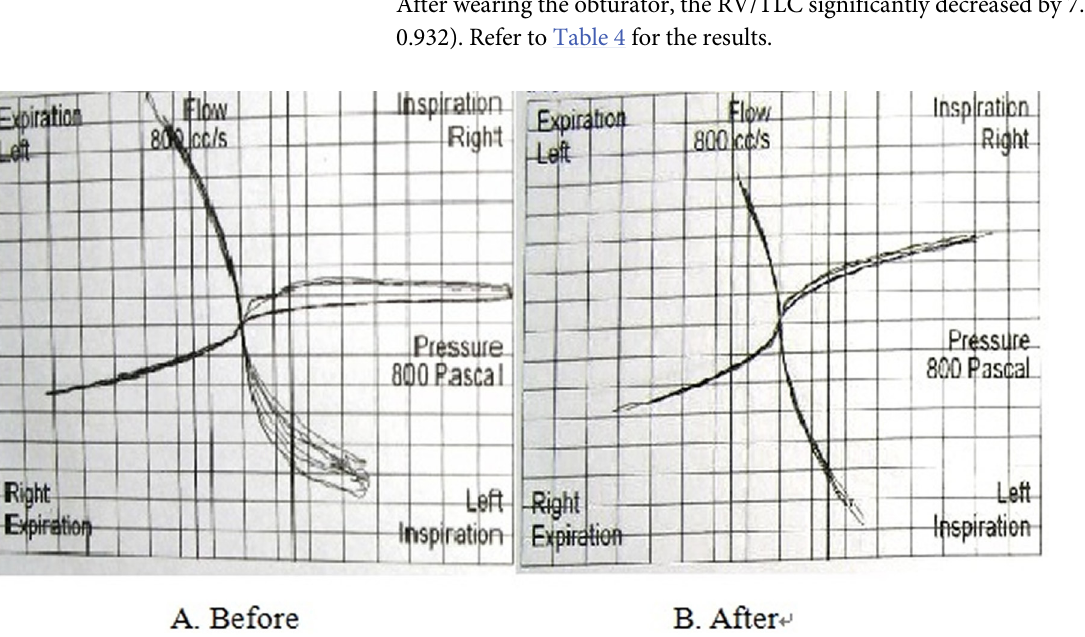
Fig 3. The nasal cavity pressure-flow curves of a patient before and after obturator placement (the right side contains the defect). A. Before obturator placement, the airflow of the ill side was significantly smaller than that of the healthy side; during inspiration, airflow was not steady or consistent. B. After obturator placement, the airflow on both sides increased during inspiration and